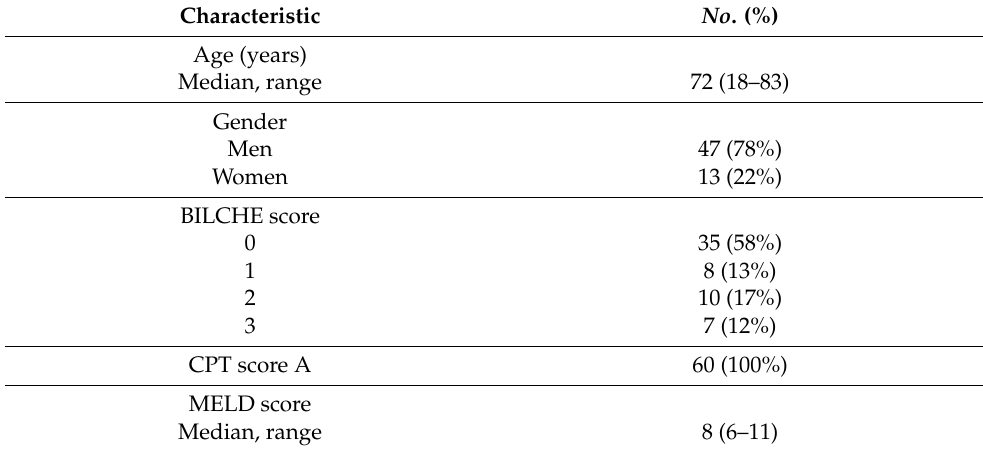
Table 1. Baseline